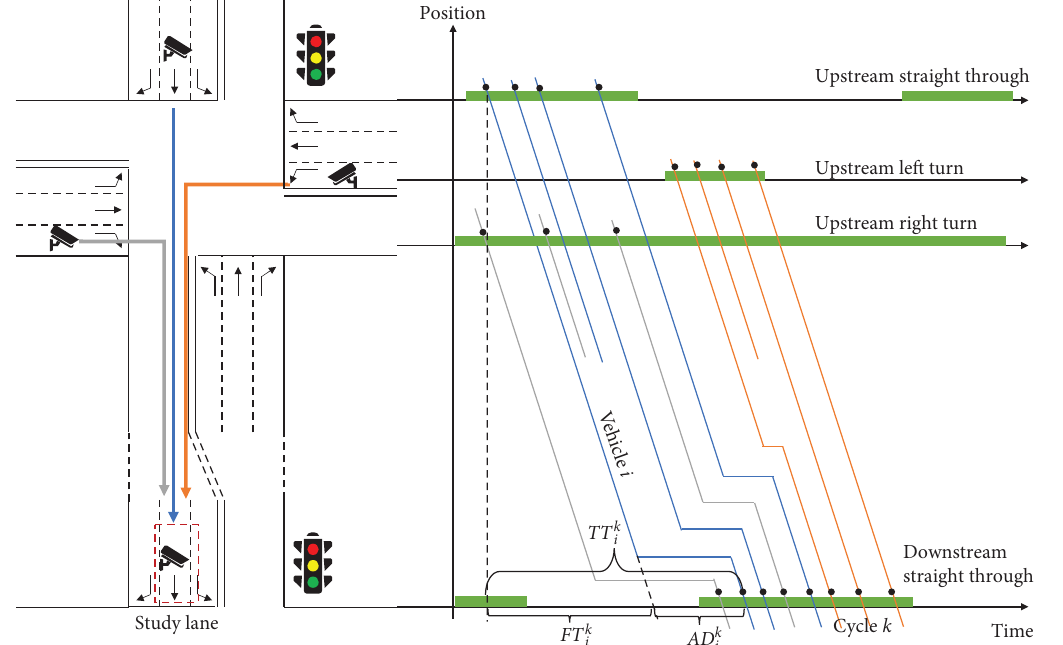
Figure 3: Te illustration of vehicle detections by multisection LPR